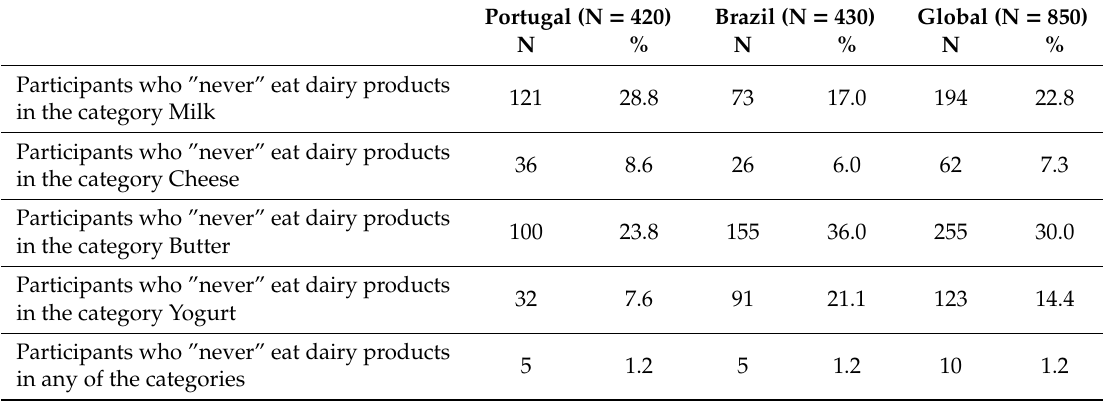
Table 13. Participants who “never” consume dairy products in Portugal and